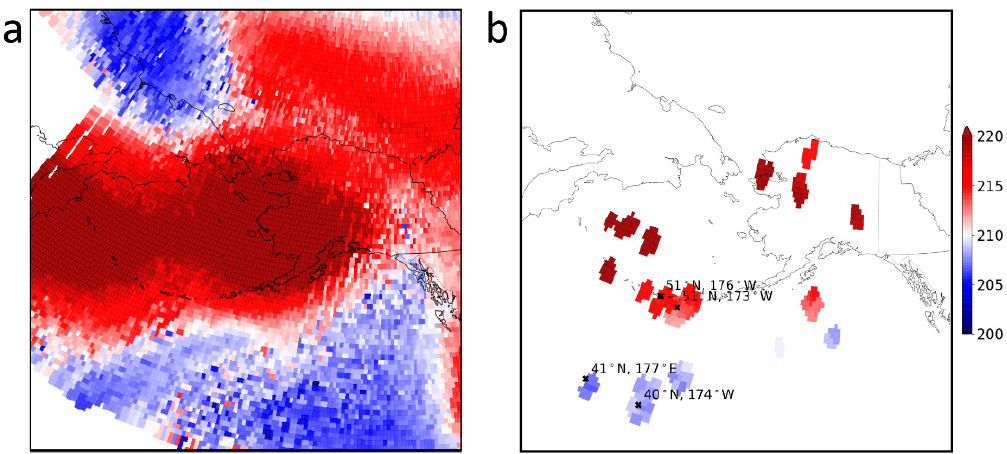
Figure 3. A National Oceanic and Atmospheric Administration Unique Combined Atmospheric Processing System (NUCAPS) horizontal slice along the 200 hPa isobar on 26 February 2018 over the study domain, 40–80 ◦ N, 169 ◦ E–131 ◦ W. ( a ) Several combined overpasses between 1100 and 1700 UTC and ( b ) matchups between with Constellation Observing System for Meteorology, Ionosphere, and Climate (COSMIC) profiles within 150 km for the same time period. Blue coloring indicates where the air temperature is below 208 K ( − 65 ◦ C) to distinguish the presence of a CAA event. Profiles annotated in ( b ) are shown in Figure 4.